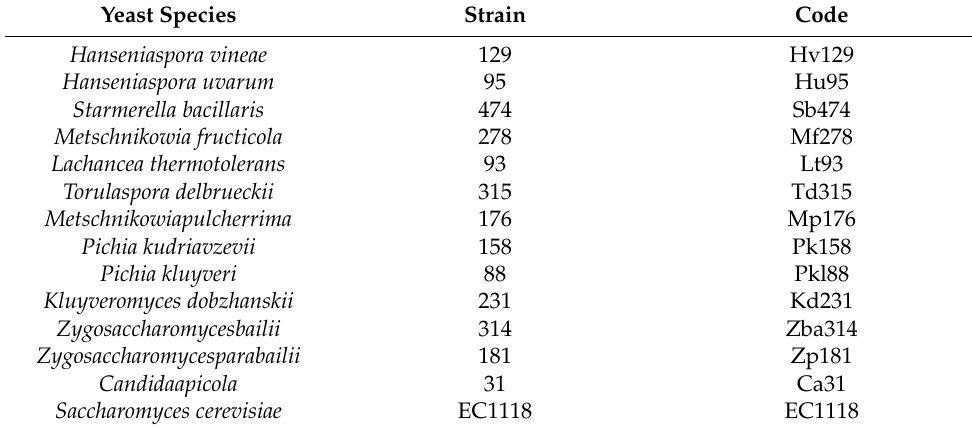
Table 1. Yeast strains used in this